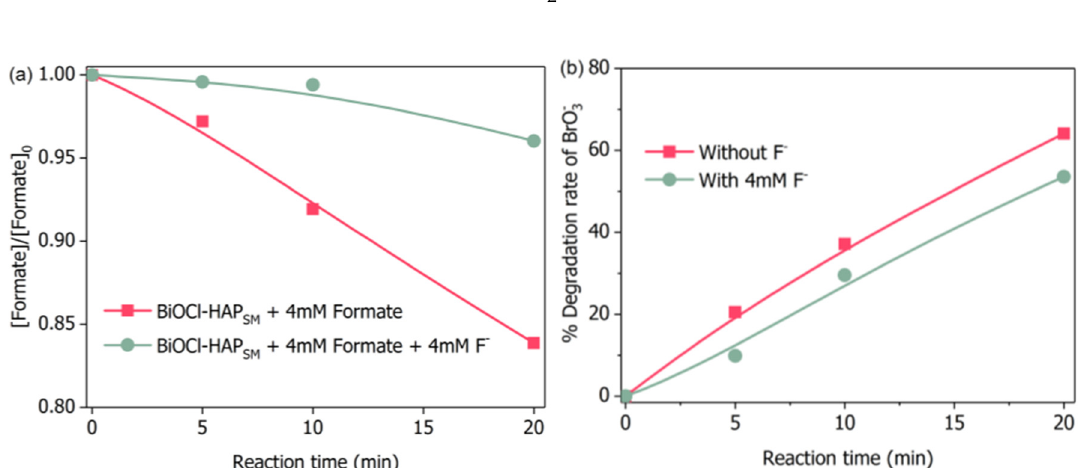
Figure 8. ( a ) Adsorption of formate by BiOCl-HAP SM in presence or absence of F − and ( b ) effect Figure 8. ( a ) adsorption of formate by BiOCl-HAP SM in presence or absence of F (cid:2879) and ( b ) effect of F (cid:2879) of F − on the degradation of bromate. Conditions: BiOCl-HAP SM dose 0.5 g · L − 1 , [BrO − F (cid:2879) on the degradation of bromate. Conditions: BiOCl-HAP SM dose 0.5 g·L − 1 , [ BrO (cid:2871)(cid:2879) ] 0 = 6.6 μ M, [Formate] 0 = 4.0 mM, [F − ] 0 = 4.0 mM, pH = 7.0, 25 ◦ [Formate] 0 = 4.0 mM, [ F (cid:2879) ] 0 = 4.0 mM, pH = 7.0, 25 °C.